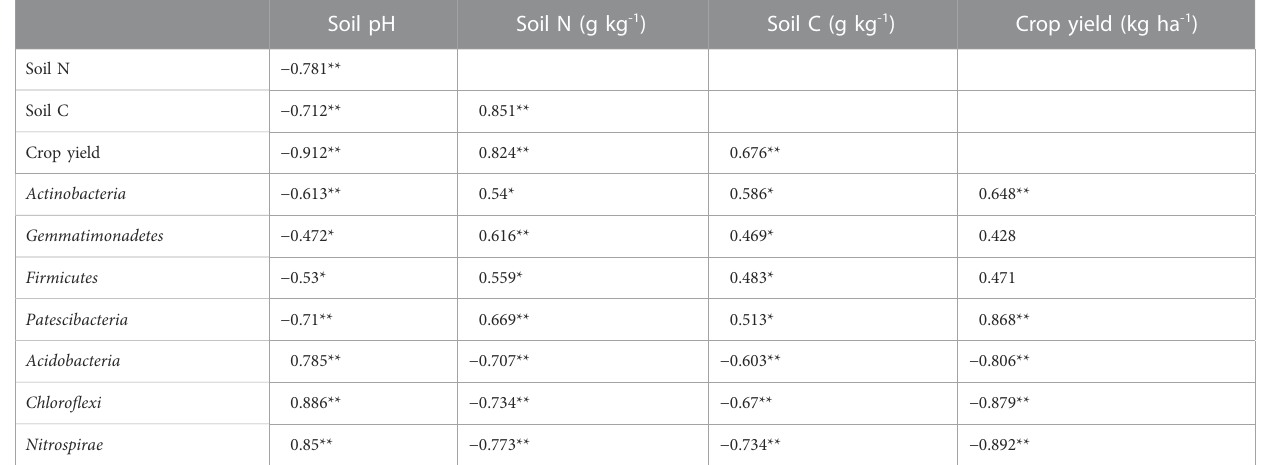
TABLE 1 Correlation among crop yield, soil properties, and soil microbial